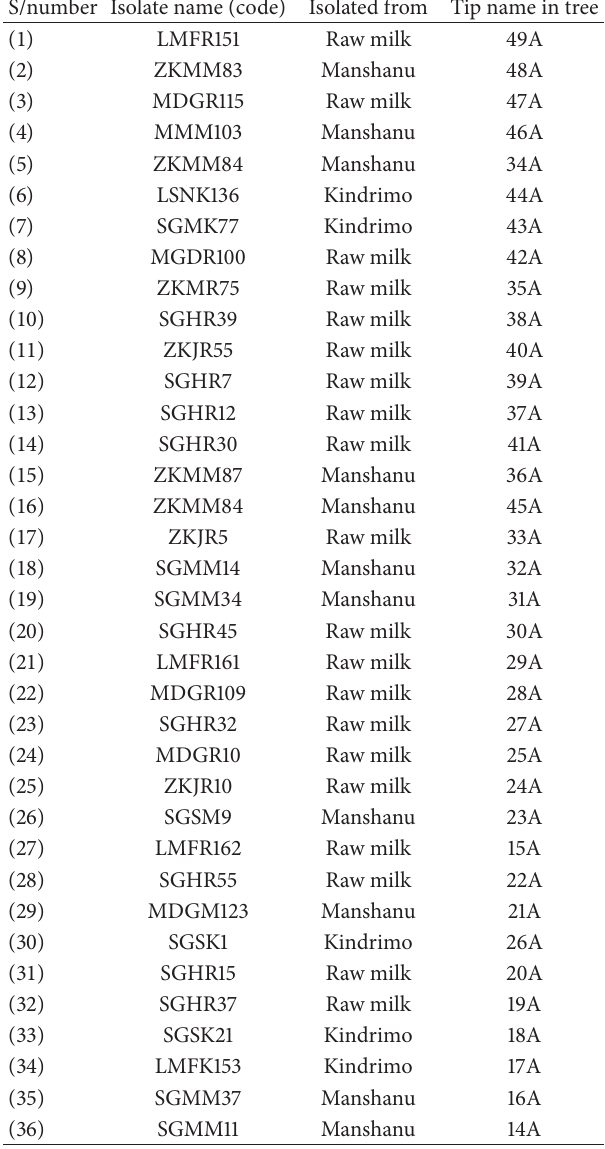
Table 1: Listeria monocytogenes characteristics. S/number Isolate name (code) Isolated from Tip name in